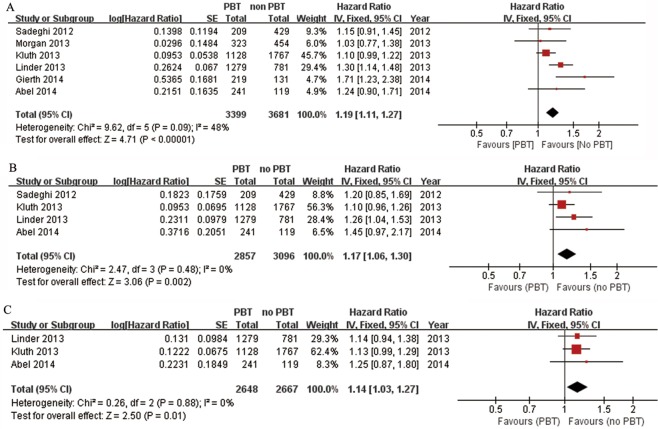
Fixed-effect model forest plots of HRs.(A) All-cause mortality, (B) Cancer-specific mortality, (C) Cancer recurrence. SE: standard error; CI: confidence interval; IV: inverse variance.